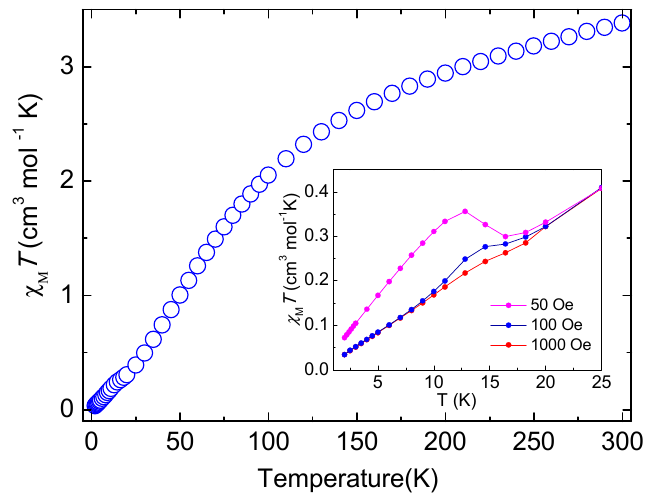
Figure 7. Plot of χ M T vs. T of compound 2 in an applied field of 1 kOe from 2 to 300 K. The insets give the χ M T vs. T at low temperature measured under the indicated external